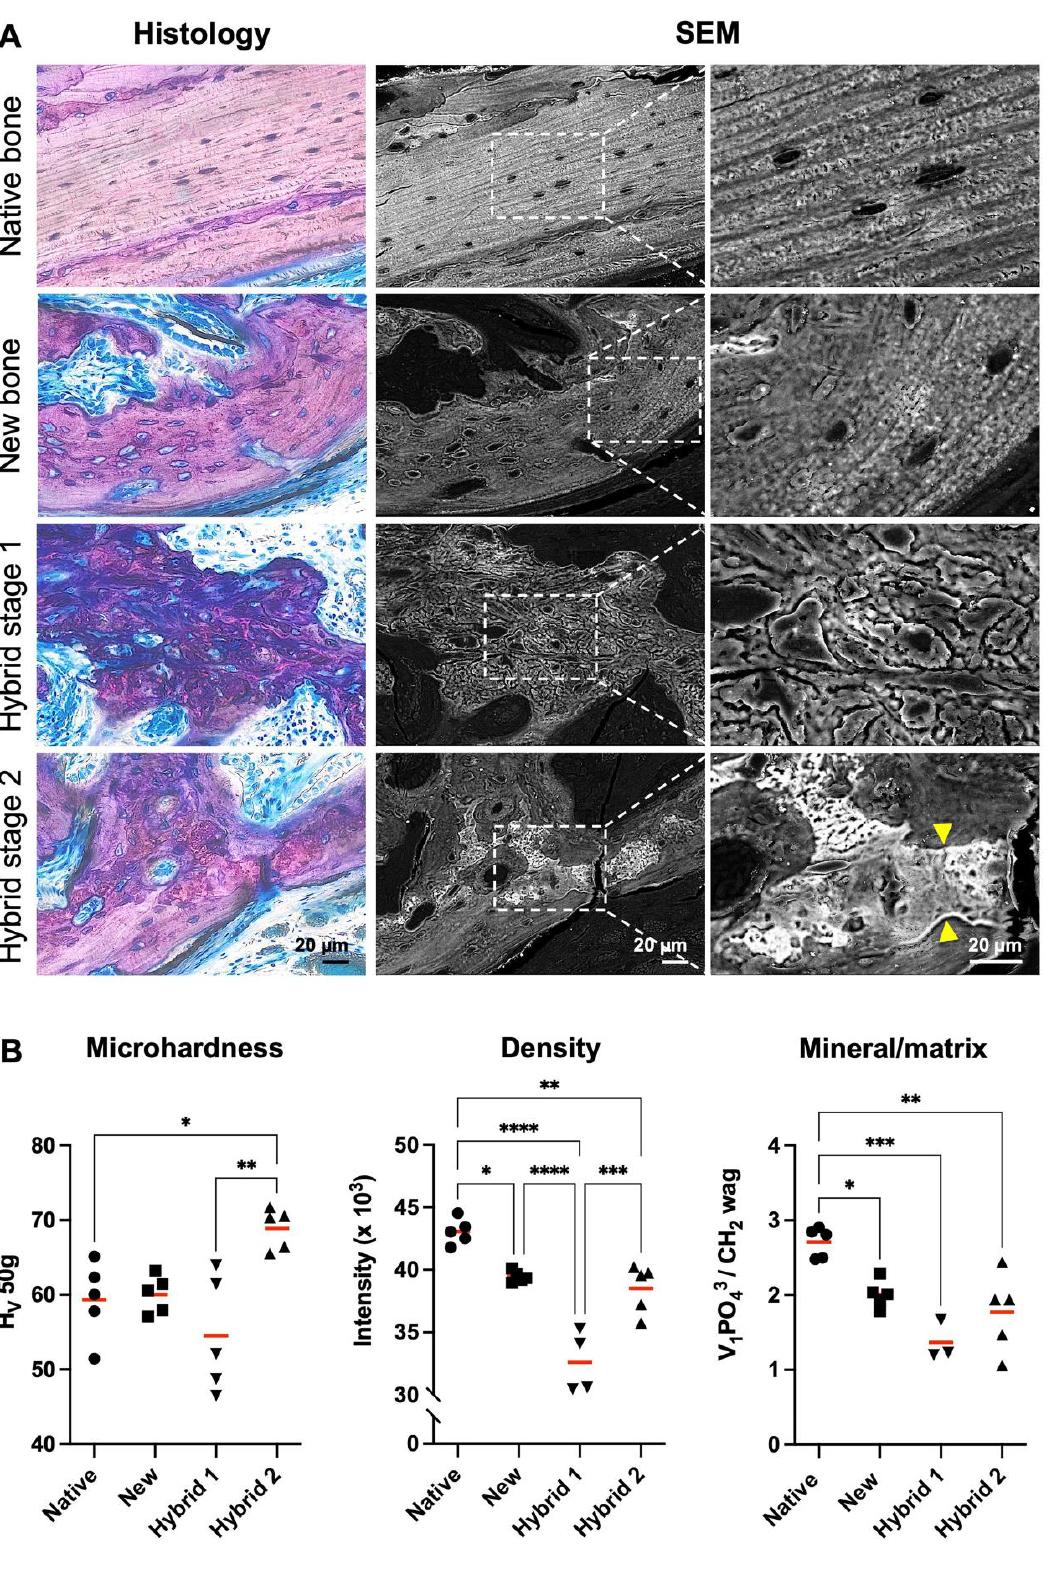
Figure 7. Characterization of new and hybrid bone. ( A ) Representative histological and corre- sponding scanning electron microscopy (SEM) images of native calvarial bone, new bone, hybrid